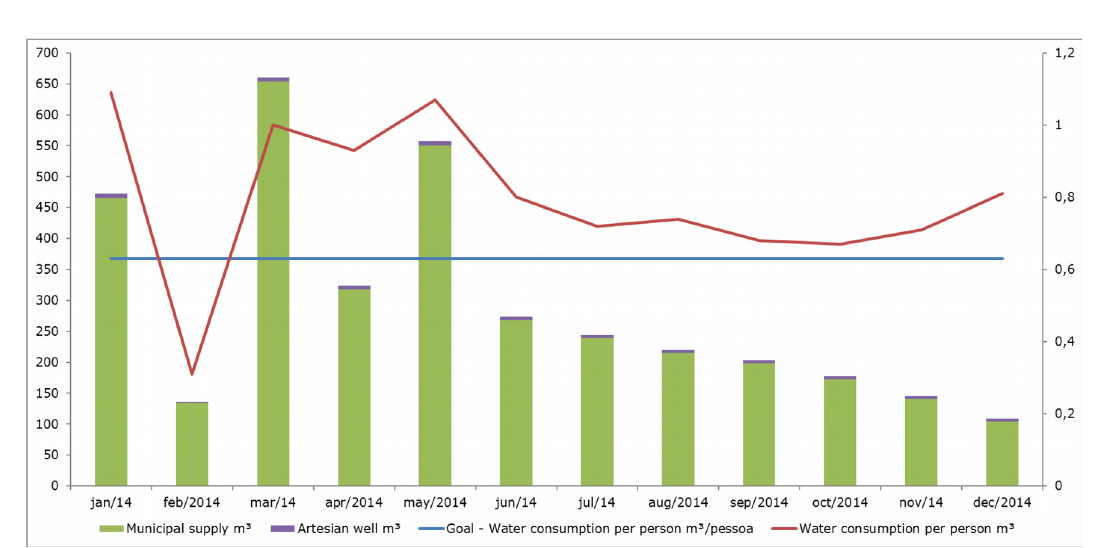
Figure 8. Monthly indicators for checking water consumption